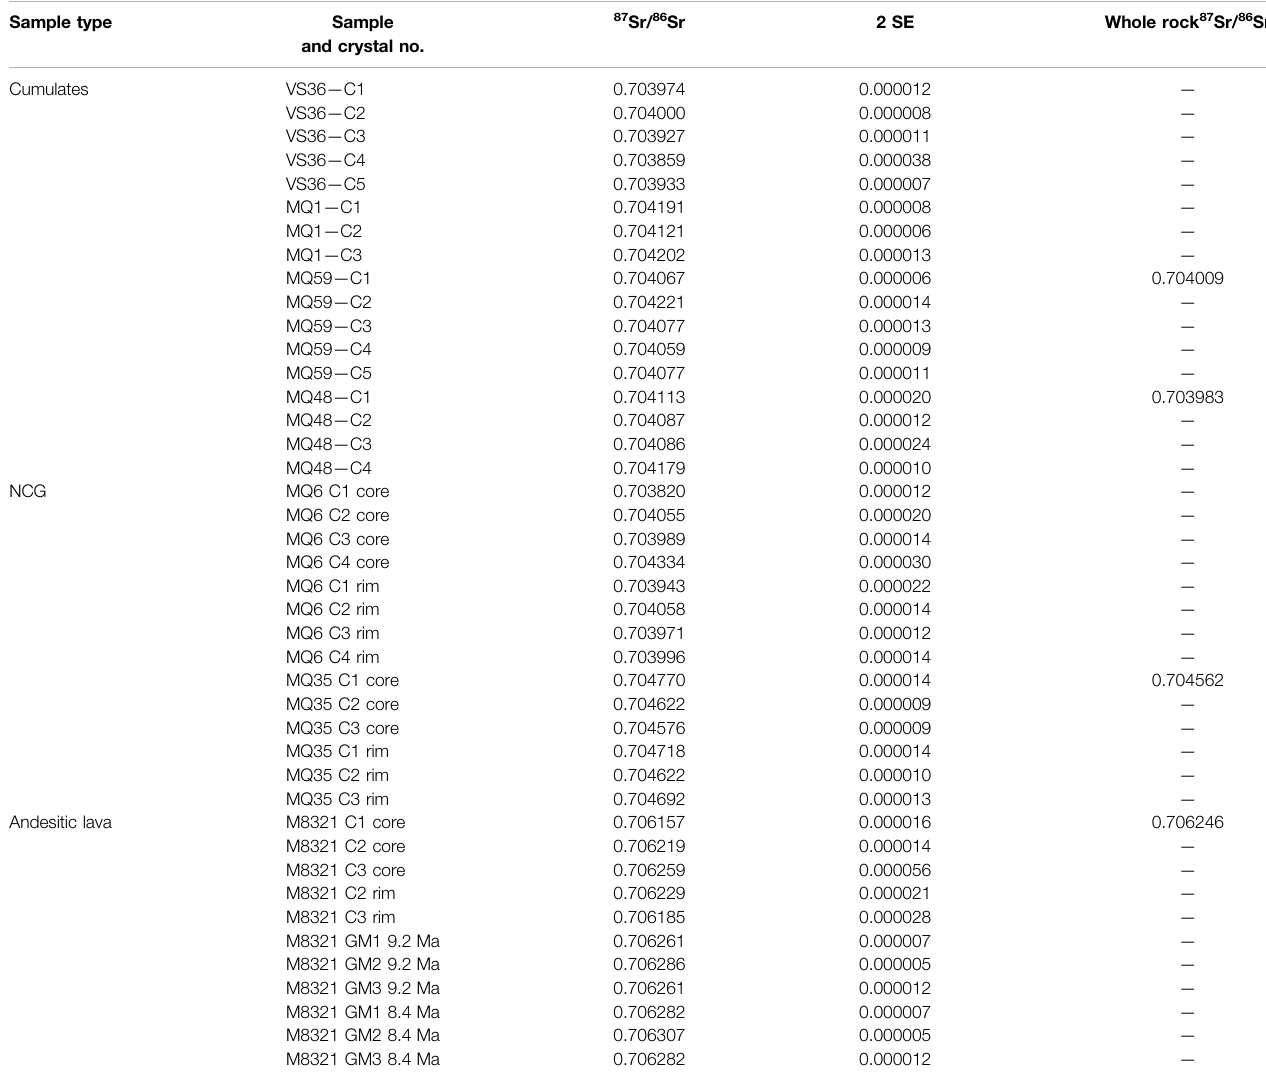
TABLE1| 87 Sr/ 86 Srofindividualplagioclaseincumulates,andcoreandrimzonesofplagioclaseinNCG ’ sandlava.Wholerock 87 Sr/ 86 Sralsoshownifavailable.Lavawhole rock value from Davidson, (1986). SE (cid:1) standard